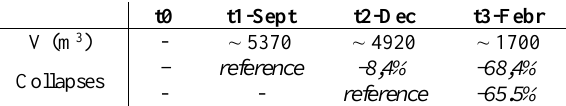
Table 2. Preliminary evaluation on mean collapsed volumes. For the time being, no metric information collected on T0